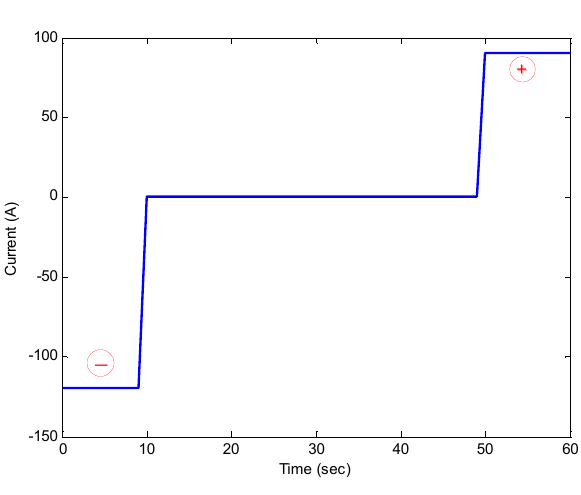
Figure 5. A single HPPC test profile.